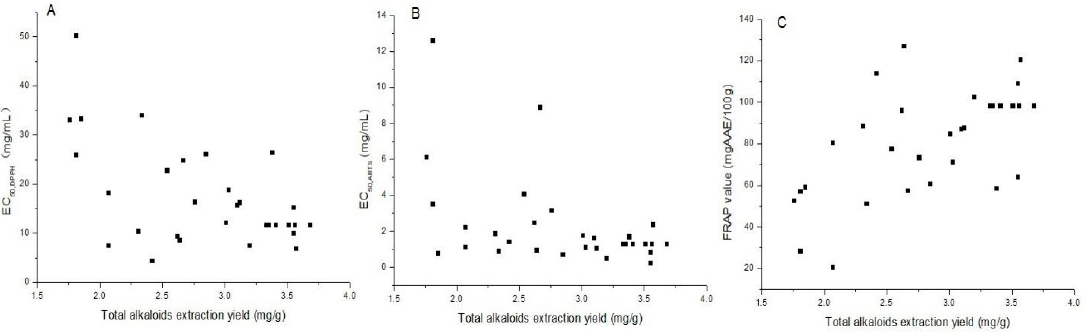
Figure 7. Antioxidant activities and correlation with the extracts of SFE: ( A ) DPPH-RSA; ( B ) ABTS-RSA; and ( C ) FRAP.